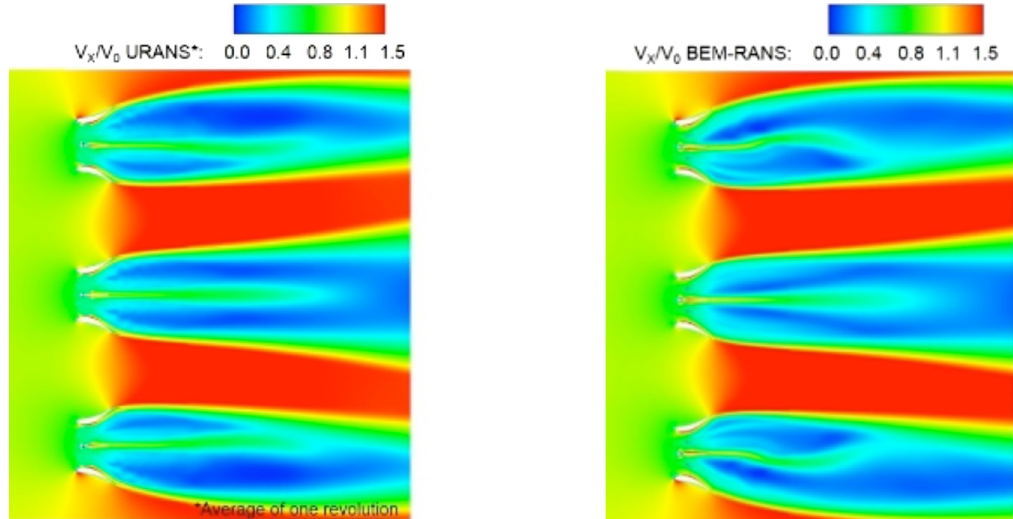
Fig. 11. Row of three HPSs in a channel. Left : averaged (over a period of rotation) velocity contours computed using the reference URANS approach. Right : steady velocity contours computed using the BEM-RANS